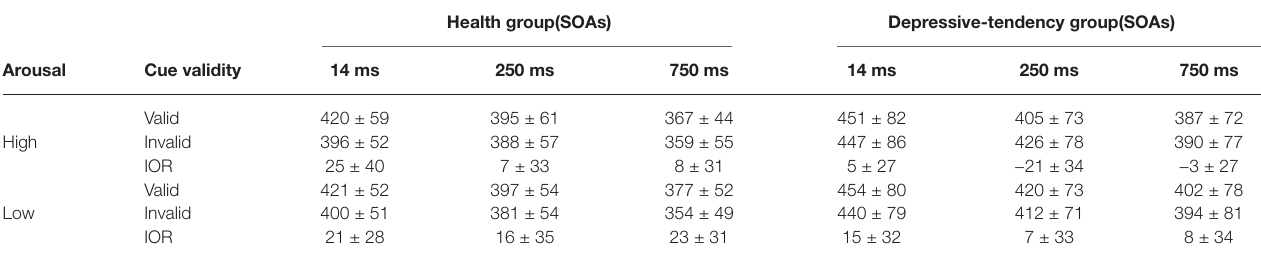
TABLE 2 | Response time under different conditions (M ± SD,